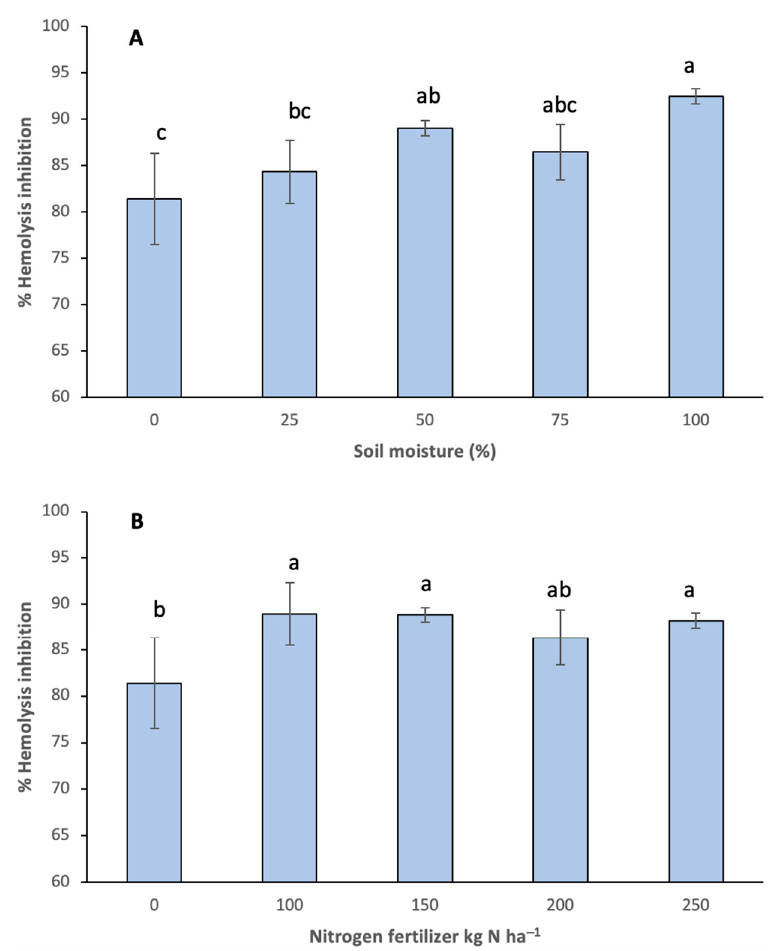
Figure 4. Erythroprotective effect reported in percentage inhibition of hemolysis of onion bulb extracts from different ( A ) soil moistures and ( B ) nitrogen fertilization. Different letters indicate significant difference ( p < 0.05). Media ± standard deviation of three repetitions.